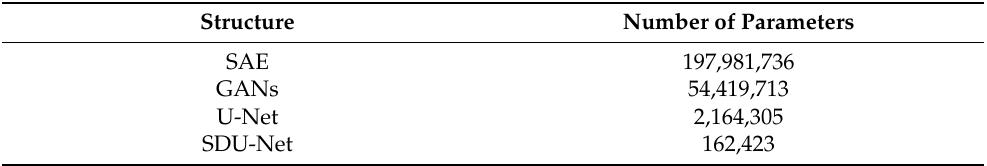
Table 2. Number of parameters of the implemented 3D reconstruction algorithms. The parameters of the GANs refer to the generator